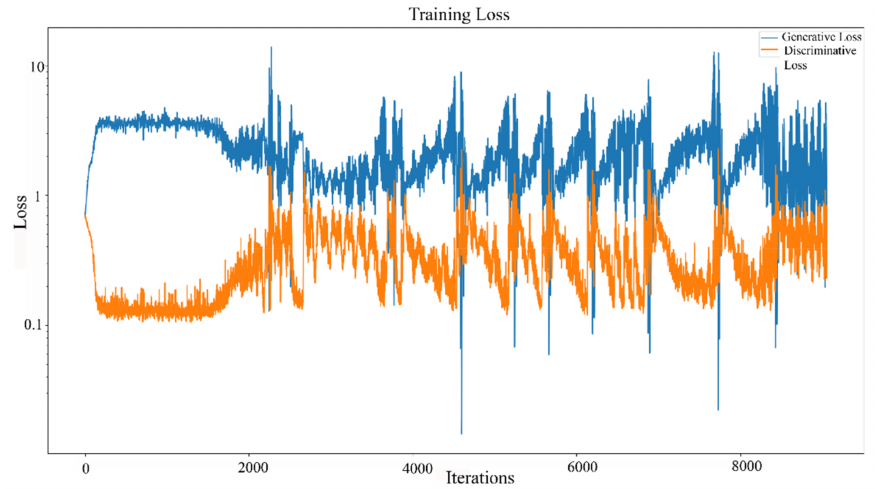
Figure 7. GAN network training loss